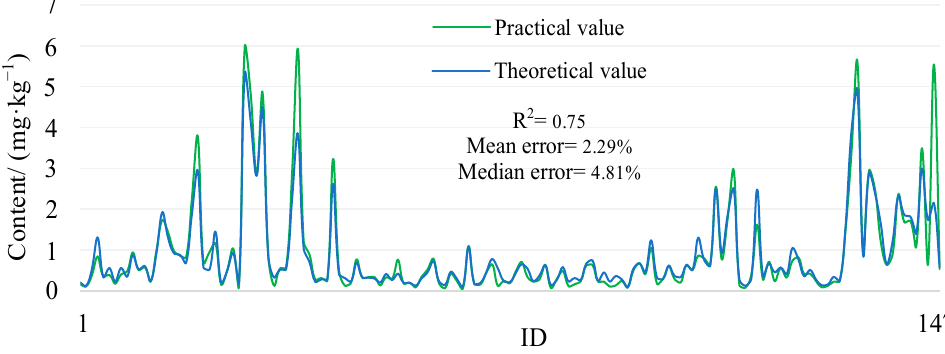
Figure 5. Comparison of risk values for spatial pollution of cadmium in soil from abandoned lead/zinc mine.